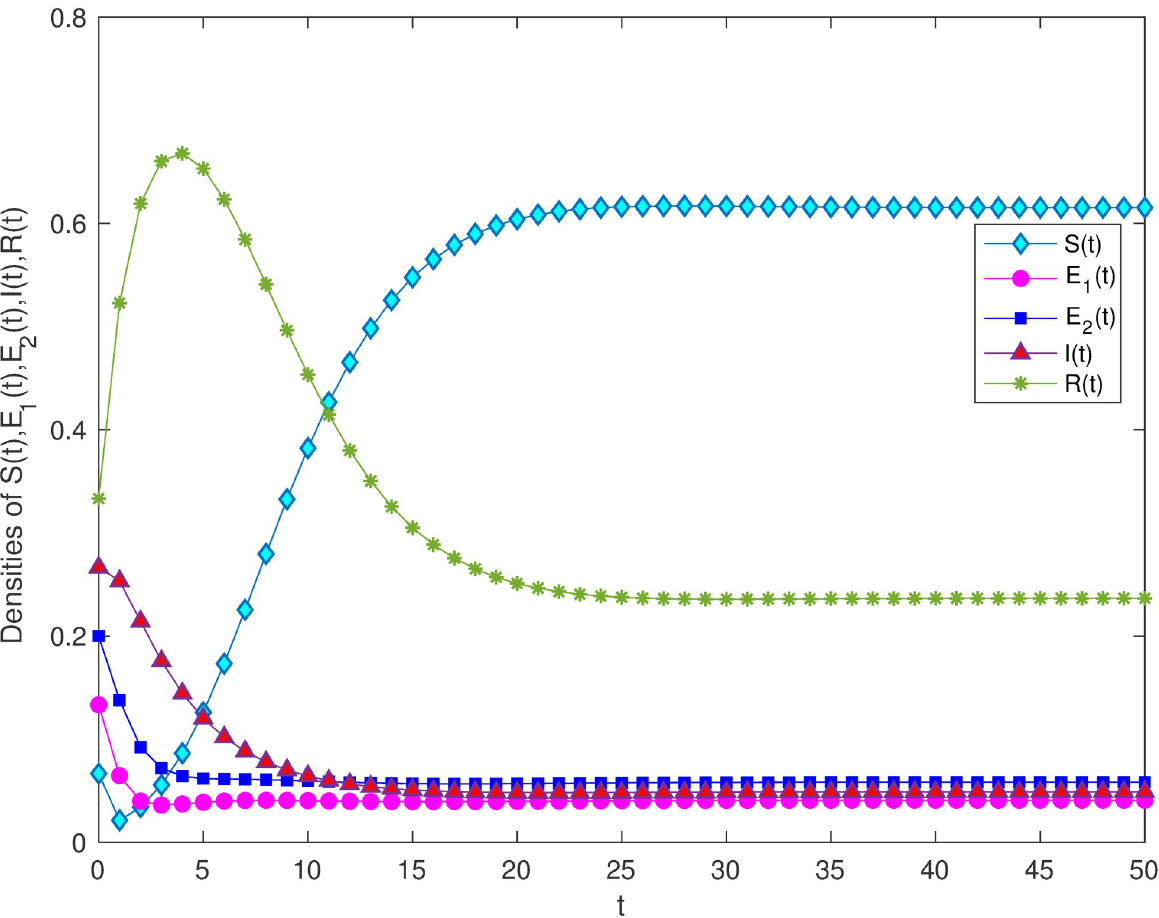
Fig 3. The stability of information-existence equilibrium E � of system 1 with R 0 > 1.